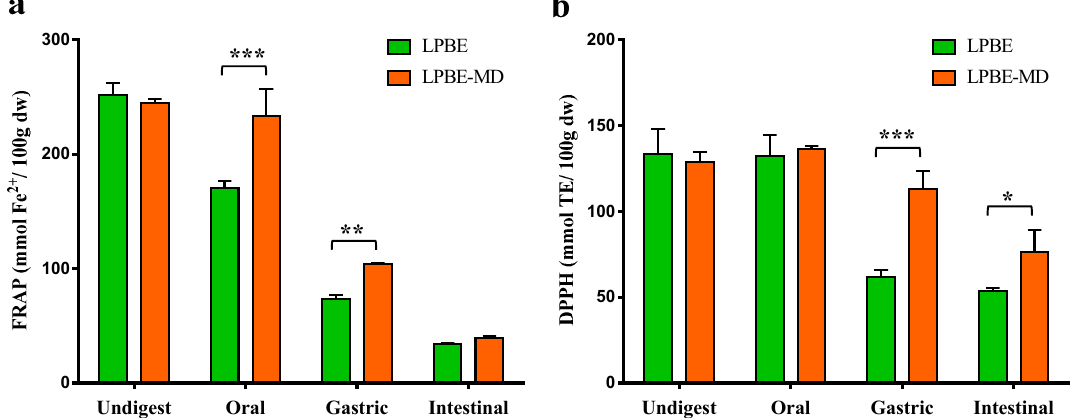
Figure 3. Antioxidant activity by FRAP ( a ) and DPPH ( b ) of non-encapsulated (LPBE) and encapsulated (LPBE-MD) PBE before and after gastrointestinal digestion. Values are expressed as mean ± SD of three experiments. * p < 0.05, ** p < 0.01, *** p <